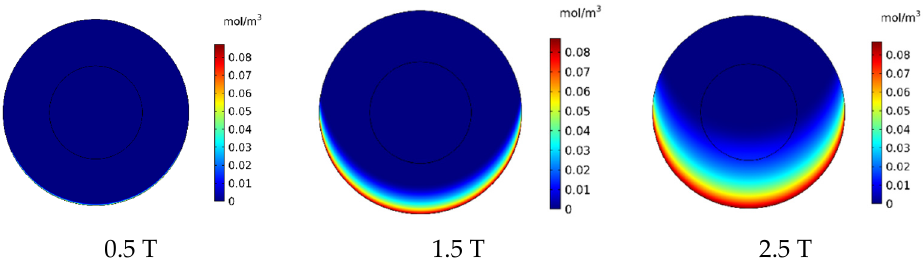
Figure 16. Comparison of the mean concentration of free drug ( C F ) in the tumor after 60 min of treatment for different applied magnetic strengths.